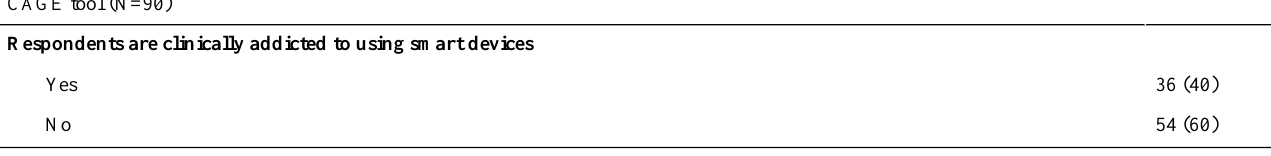
Table 9. Smart device use addiction score.